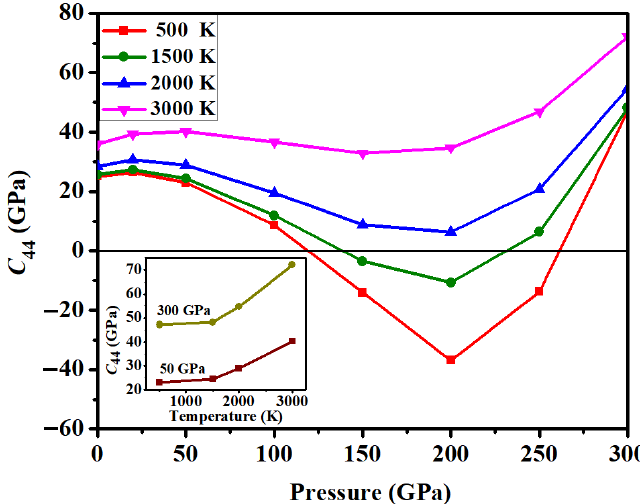
Figure 10. Calculated C 44 of BCC vanadium as a function of pressure under different electronic temperatures. (By the courtesy of Ref. [54]).